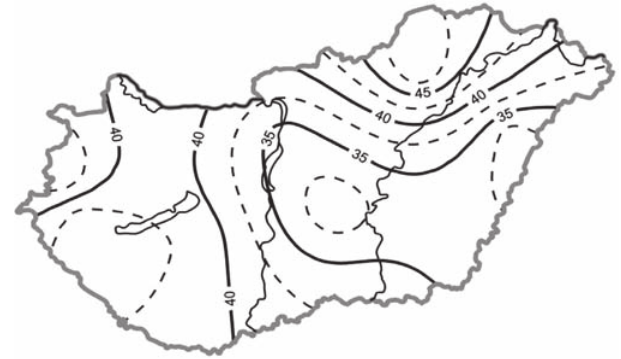
Figure 6 – The mean values of coeffi cients of variation (CV) of the absolute daily maxima of precipitation in spring measured at 16 stations over a period of 1951–2010